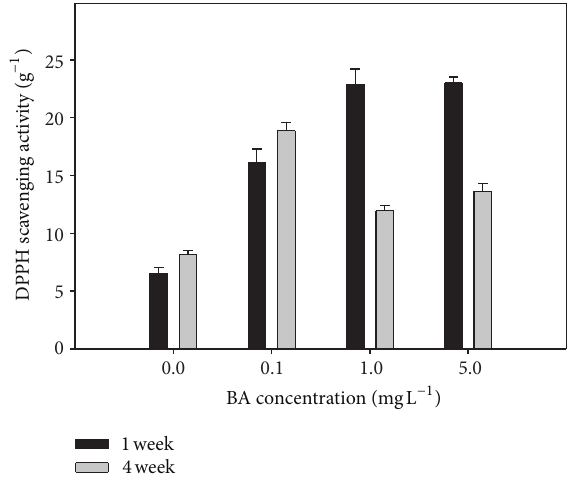
Figure 3: Effect of BA concentration on antioxidant capacity of C. heterophyllus shoots after 1 or 4 weeks of culture in MS/2 liquid media. Vertical bars represent means ± standard